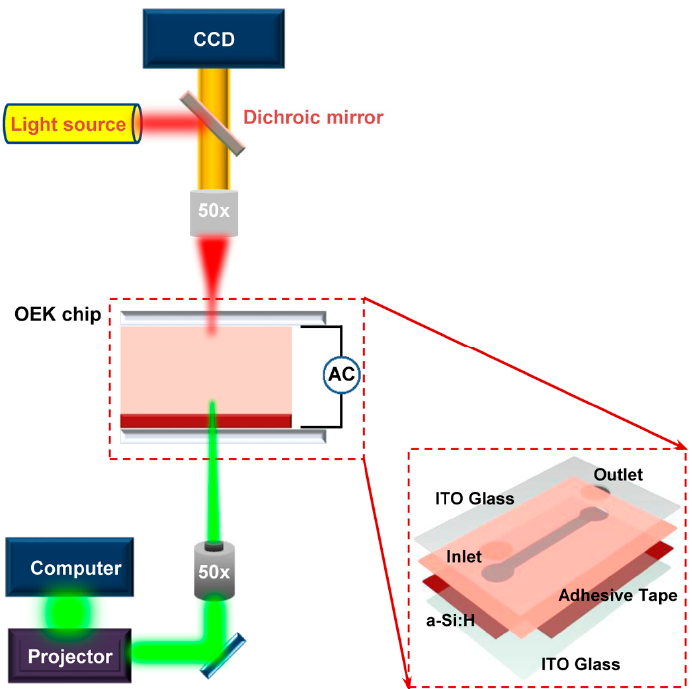
Figure 1. Schematic illustration of the experimental setup for the optically-induced electrokinetics (OEK) platform. The inset is the exploded-view illustration of the OEK chip.